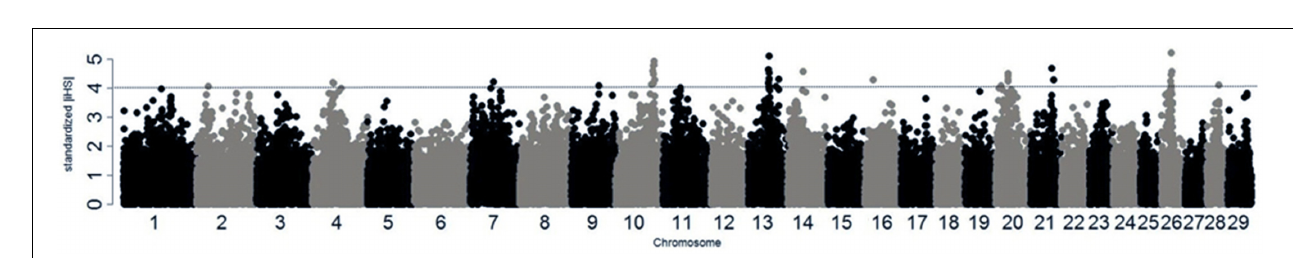
Kenyan Friesian; Green line, Kenyan Crossbred. Frequency of the most common haplotype in each breed is shown. y axis is frequency of most frequent haplotype and x axis shows genomic position (Mb).